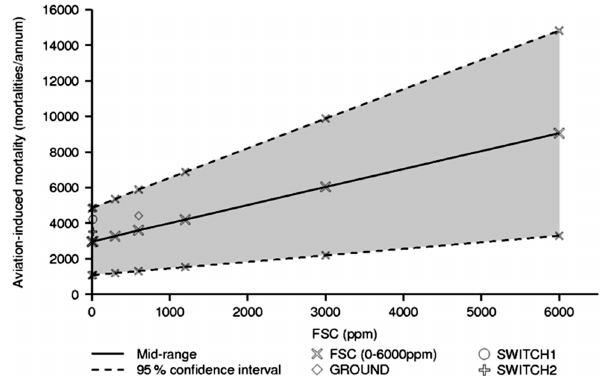
Figure 6. Estimated global aviation-induced mortality as a function of FSC, and changes in vertical aviation emission distributions for year 2000 (Shaded region denotes the 95% confidence through ap- plication of low- and high-range cause-specific